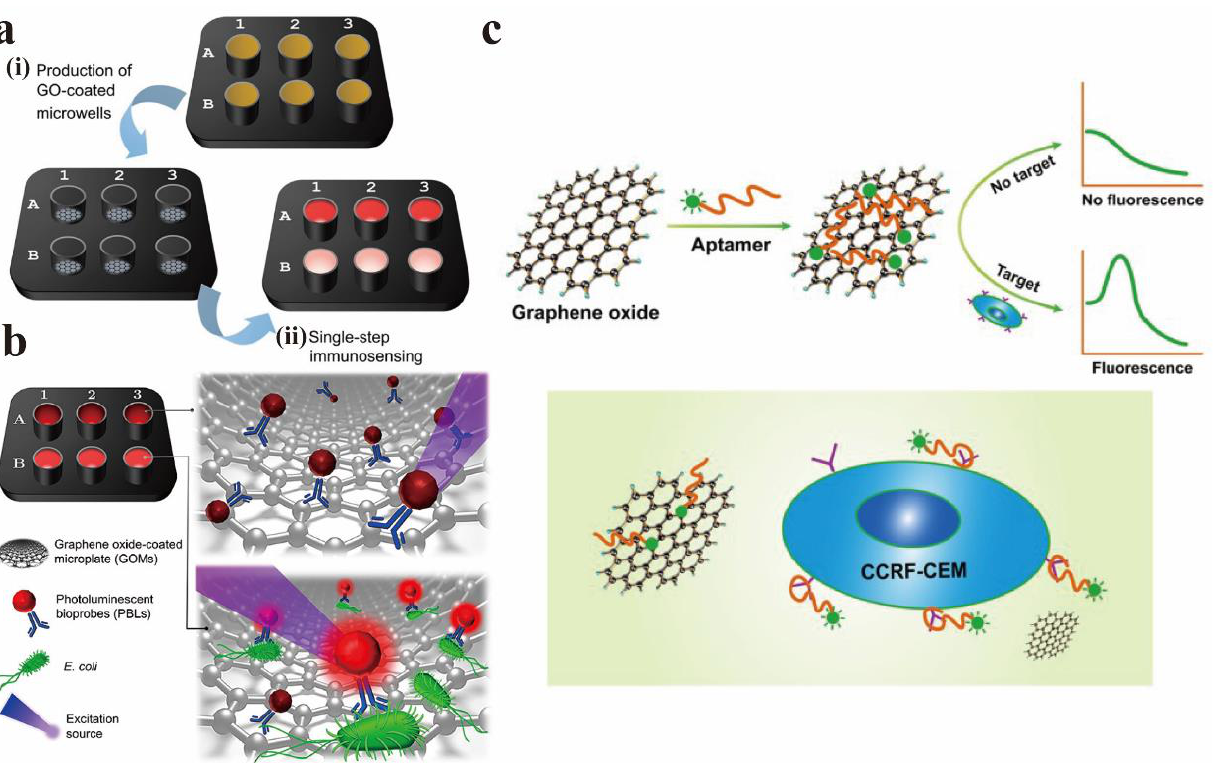
Figure 18. ( a ) GOMs preparation process diagram. ( b ) Principle of bacterial detection. Reprinted with permission from [109]. Copyright 2020, American Chemical Society. ( c ) The schematic diagram of fluorescent aptamer sensor for CCRF-CEM detection. Reprinted with permission from [110]. Copyright 2018, Springer Nature.